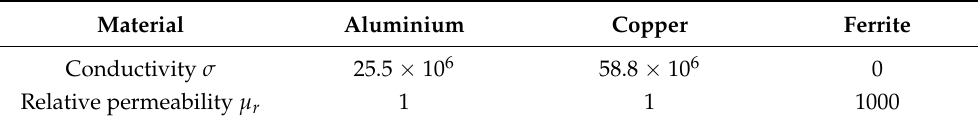
Table 1. Setting of conductivity and relative permeability of shielding material.